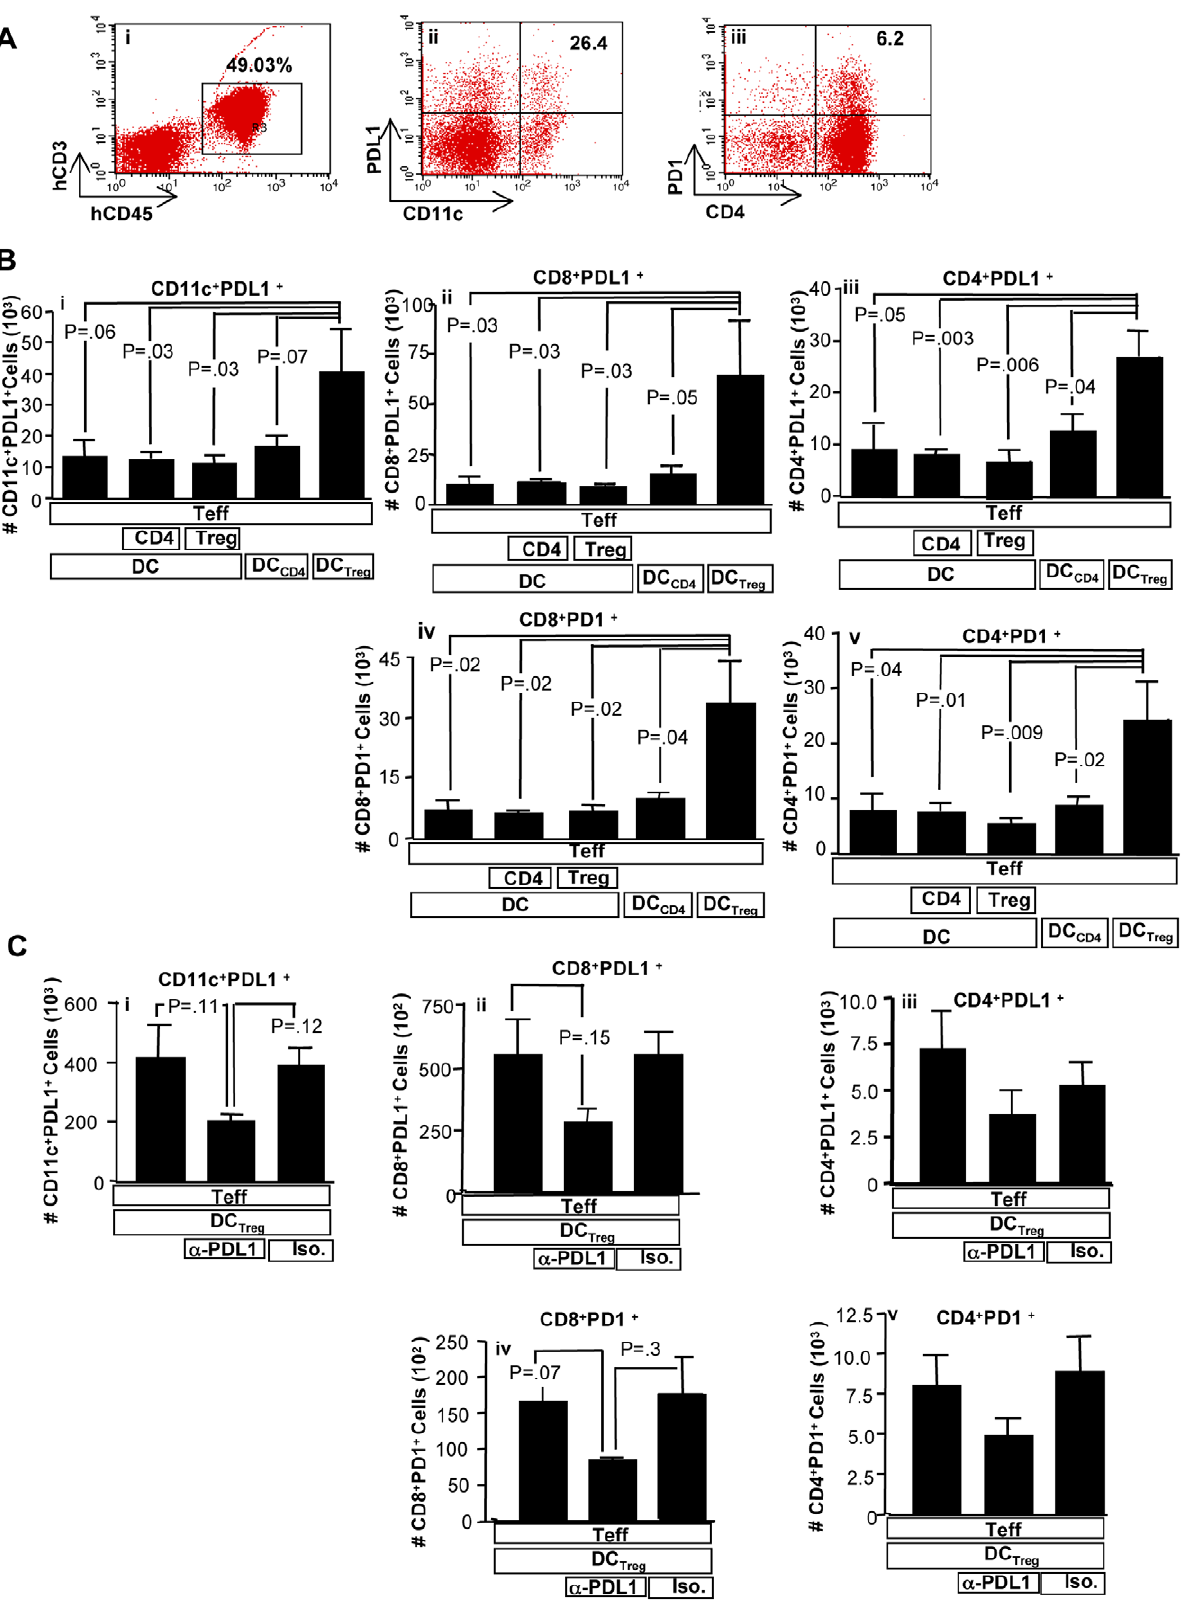
Figure 3. Treg-conditioned DC modulate effector T cells in vivo via PD-L1. A xenogeneic transplantation model utilized Rag2 2 / 2 c c 2 / 2 mice that received some combination of human cells, as indicated, including: CFSE-labeled effector Teff cells (‘‘Teff’’); untreated DC (‘‘DC’’), control CD4- conditioned DC (‘‘DC CD4 ’’), or Treg-conditioned DC (‘‘DC Treg ’’); and ex vivo–generated control CD4 cells (‘‘CD4’’) or regulatory T cells (‘‘Treg’’). (A)